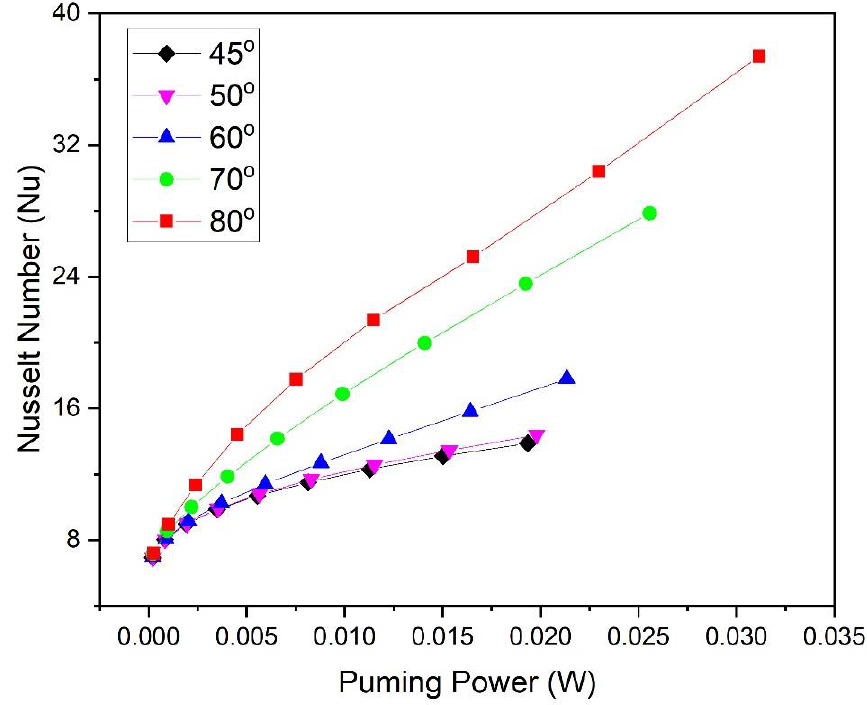
Figure 15. Dependence between Nusselt number and pumping power for different angles .